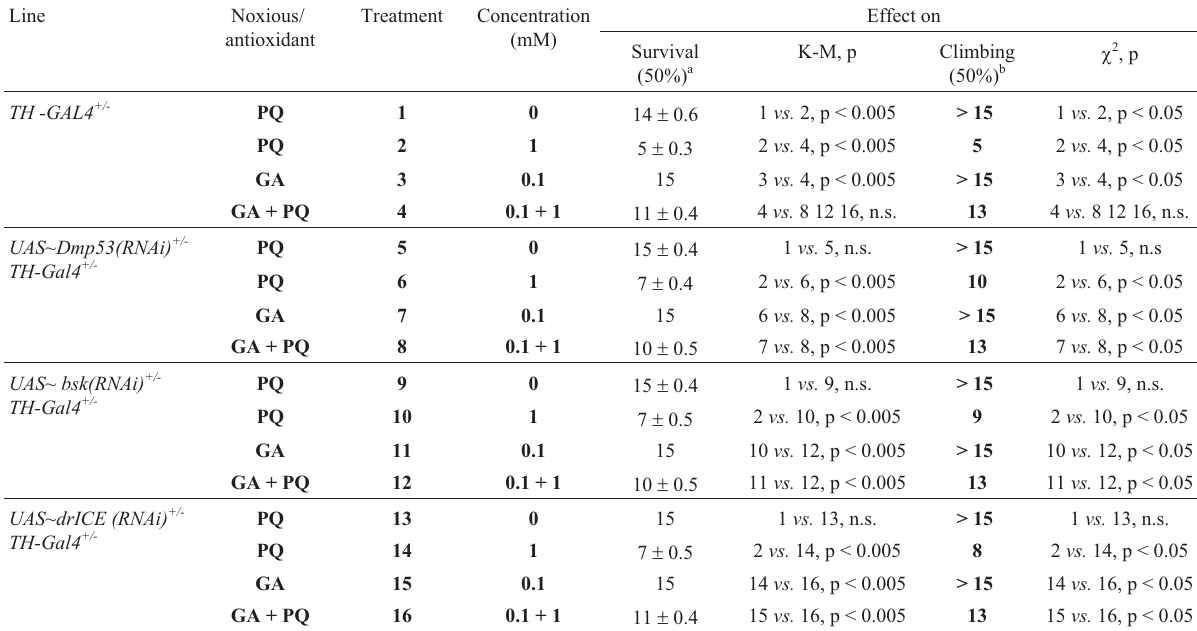
a represents number of days at which 50% of total flies have been killed. b represents number of days at which 50% of climbing ability is